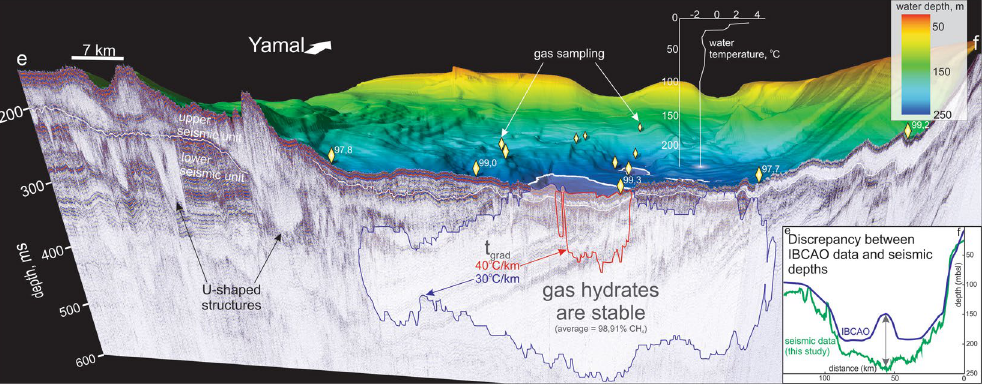
Figure 4. Fragment of a seismic line (see location e-f in Fig. 1) along which we implemented gas hydrate modeling for 30 and 40 °C/km geothermal gradients. Yellow diamonds indicate gas sampling stations. Our results show that approximately 20% of mapped ancient thermokarst may presently exist within the gas hydrate stability